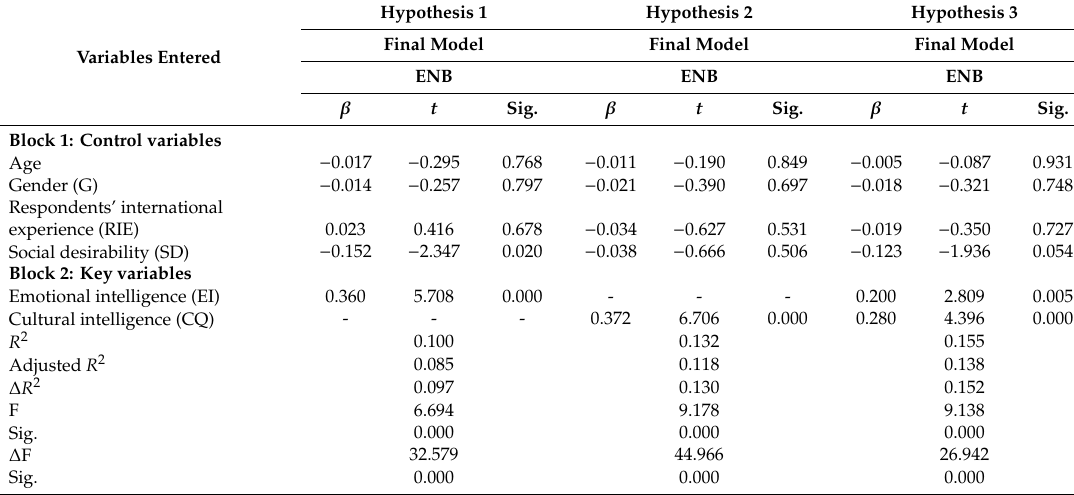
Table 5. Regression results (H1, H2, and